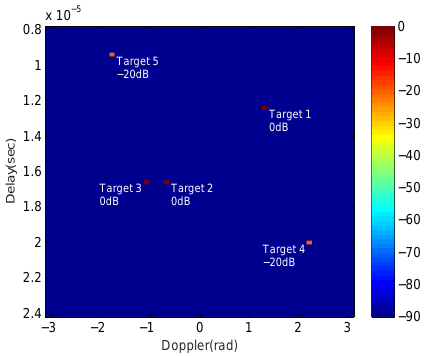
Figure 9. Illustration of target signal magnitudes and locations in the Delay–Doppler map for the fixed scenario.